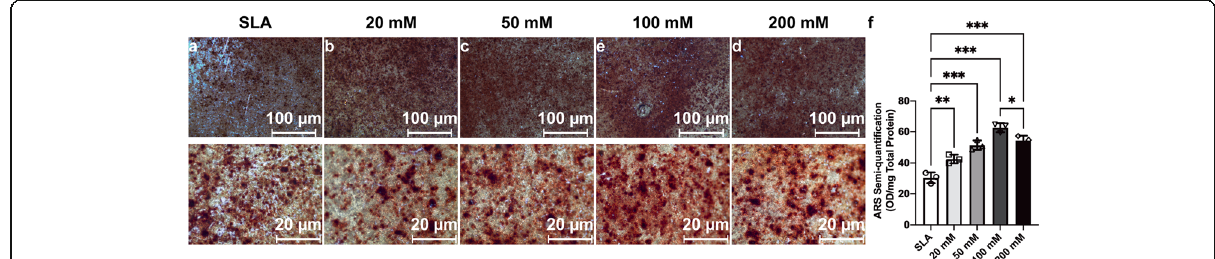
Fig. 9 Alizarin Red S (ARS) staining images of calcium deposition of BMSCs cultured on SLA surfaces ( a ) and SLA discs treated with 20 mM ( b ), 50 mM ( c ), 100 mM ( d ), 200 mM ( e ) sodium bicarbonate after cell osteogenic differentiation for 21 days. Semiquantitative results of ARS staining of BMSCs on different surfaces for 21 days ( f ). Data are presented as the mean ± standard deviation ( n = 3, * P < 0.05; ** P < 0.01; *** P <